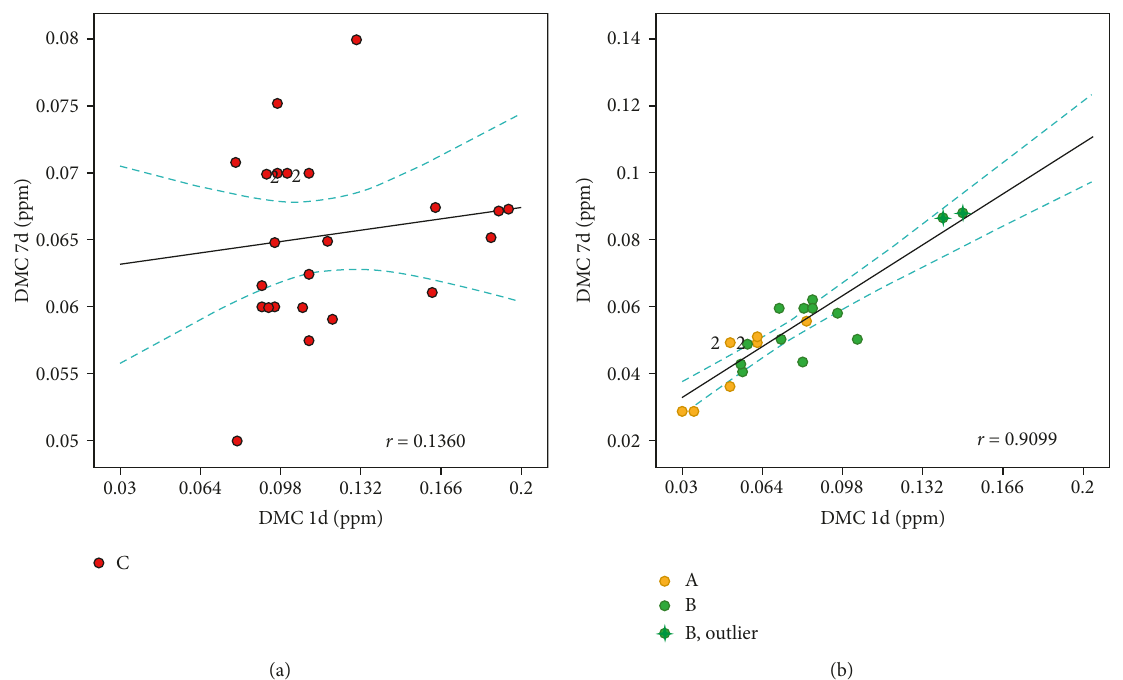
Figure 4: Correlation between the 1-day and 7-day DMC values for (a) particleboard type C (low-density) and (b) particleboard types A (standard) and B (standard, low-emission) combined. Circles represent values measured from different production batches, dotted lines represent confidence bands, and numbers before circles indicate more than one measurement at the same location. No outliers exist for (a), and two values have been marked in the figure as outliers in (b). Upper and lower fences are 0.085 and 0.045 for (a) and 0.081 and 0.024 for (b). The outliers in (b) were not excluded due to low influence on fitted values (DFFITS 0.319 and 0.524).